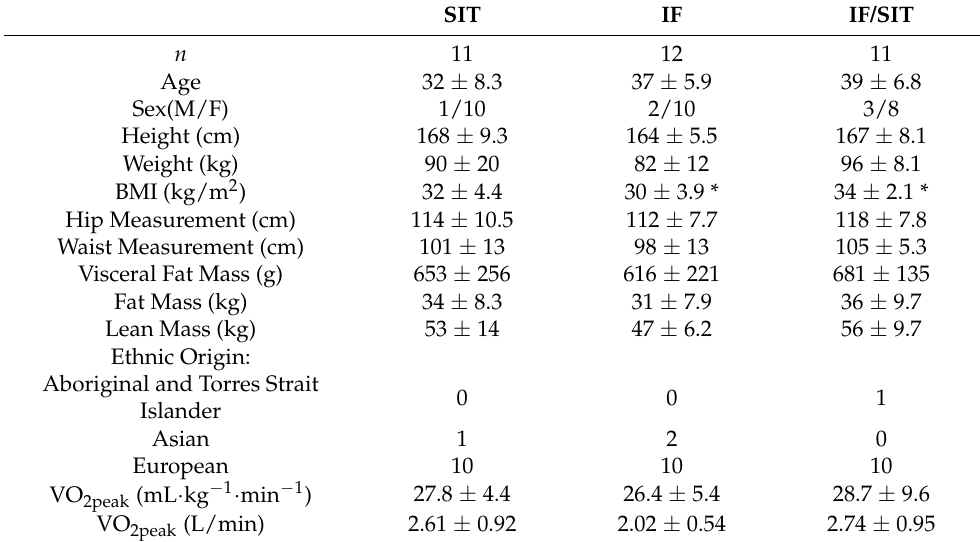
Table 1. Participant baseline